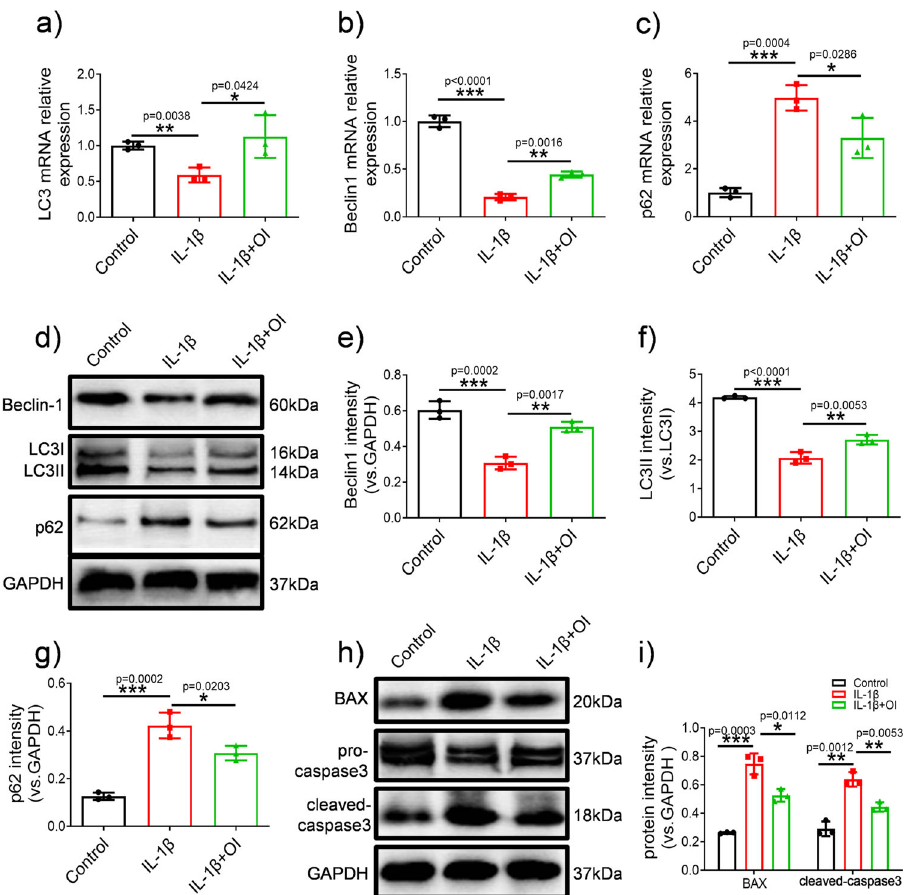
Fig. 2 OI promoted the expression of autophagy markers and inhibited the expression of apoptosis-related proteins in C28/I2 cells. a – c qRT-PCR was used to analyse the mRNA expression of LC3, Beclin-1, and p62 in chondrocytes treated with IL-1 β and OI ( n = 3). d – g WB was performed to analyse the expression of Beclin-1, LC3 and p62, which were normalised to GAPDH ( n = 3). h , i Western blotting analysis of BAX, pro-caspase3 and cleaved caspase3 protein expression normalised to GAPDH ( n = 3). Internal control was performed using GAPDH. The error bar is SD. The data are the mean ± SD. * P < 0.05, ** P < 0.01, *** P <